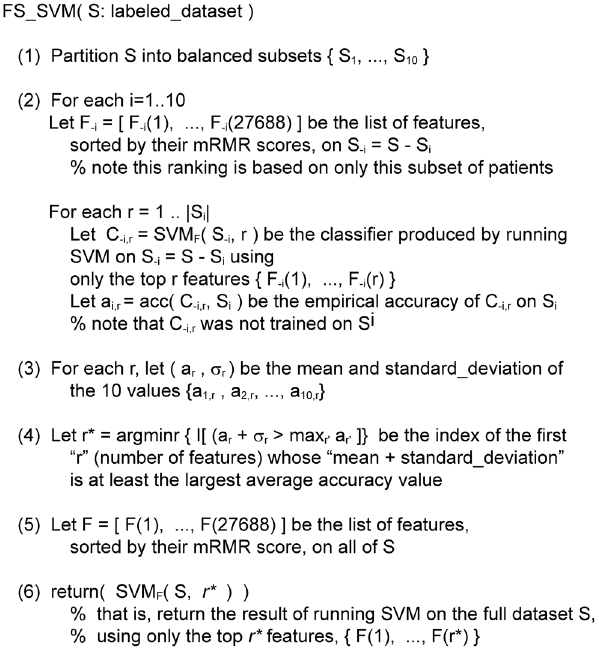
Figure 2. FS_SVM; a feature selection version of the Support Vector Machine (SVM) learner. Line 6 runs SVM on the dataset S, but uses only the r * ‘‘best’’ features, where features are ranked by their mRMR score 15 , which is computed in Line 5. Note this mRMR score combines mutual information (Eq 1) with minimum redundancy. The goal of the first 4 lines is to compute this r * value: Here, we first partition the dataset into 10 disjoint same-sized subsets {S i , i=1…10 }, which are balanced (ie, each is of the same size, and has about the same number of ER + instances). FS_SVM then considers each of these S i subsets, one by one. It first considers the remaining instances, S 2 i = S 2 S i , and computes the mRMR score for each feature with respect to this subset of instances. It then evaluates how well SVM does when using only the first r=1, 2,… of these features, in order. Here, it runs SVM, using that size-r subset of features, on the training set S 2 i , then evaluates the resulting classifier on the remaining ‘‘testing subset’’ S i . Line 4 sets r * to be the smallest value that is within 1 standard deviation of the high- water mark. See Material S1 for more details.